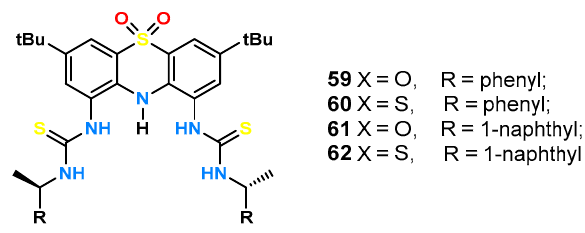
Figure 19. Phenothiazine receptors 59–62.